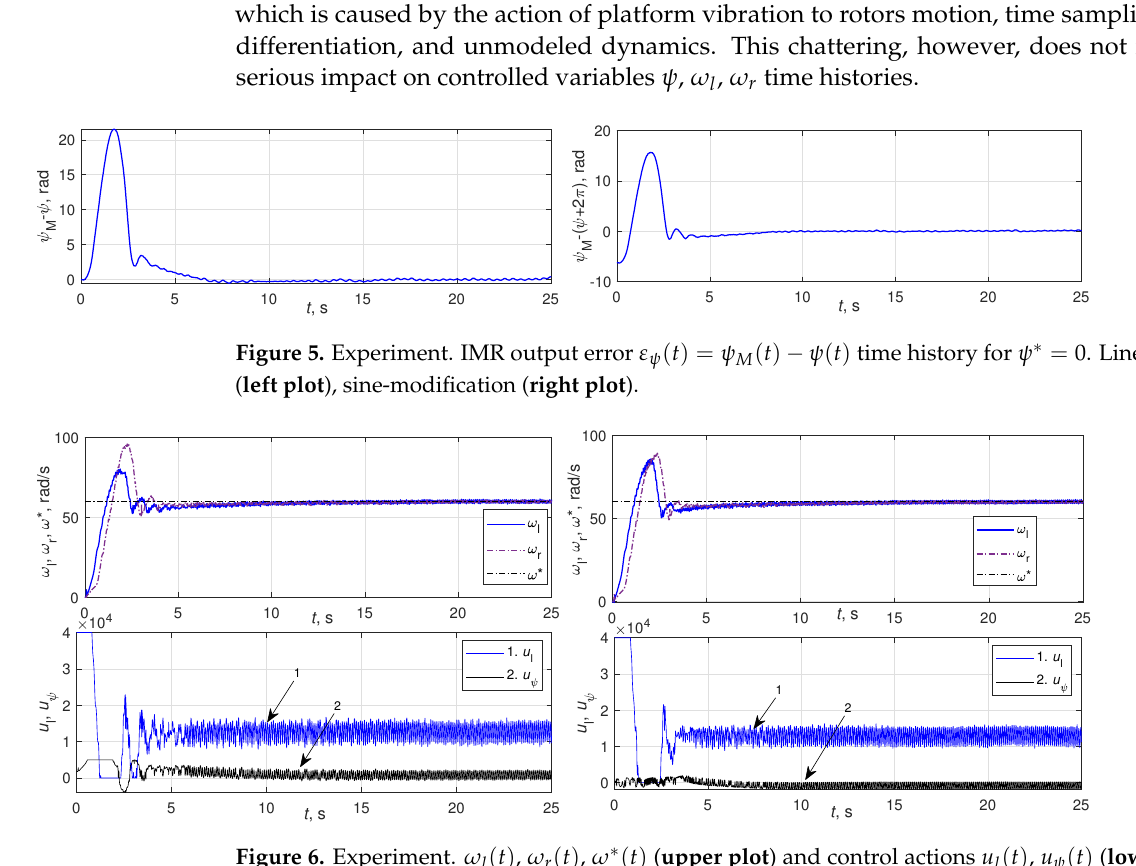
Figure 6. Experiment. ω l ( t ) , ω r ( t ) , ω ∗ ( t ) ( upper plot ) and control actions u l ( t ) , u ψ ( t ) ( lower plot ) time histories for ψ ∗ = π . Linear error ( left column ), sine-modification ( right column ).